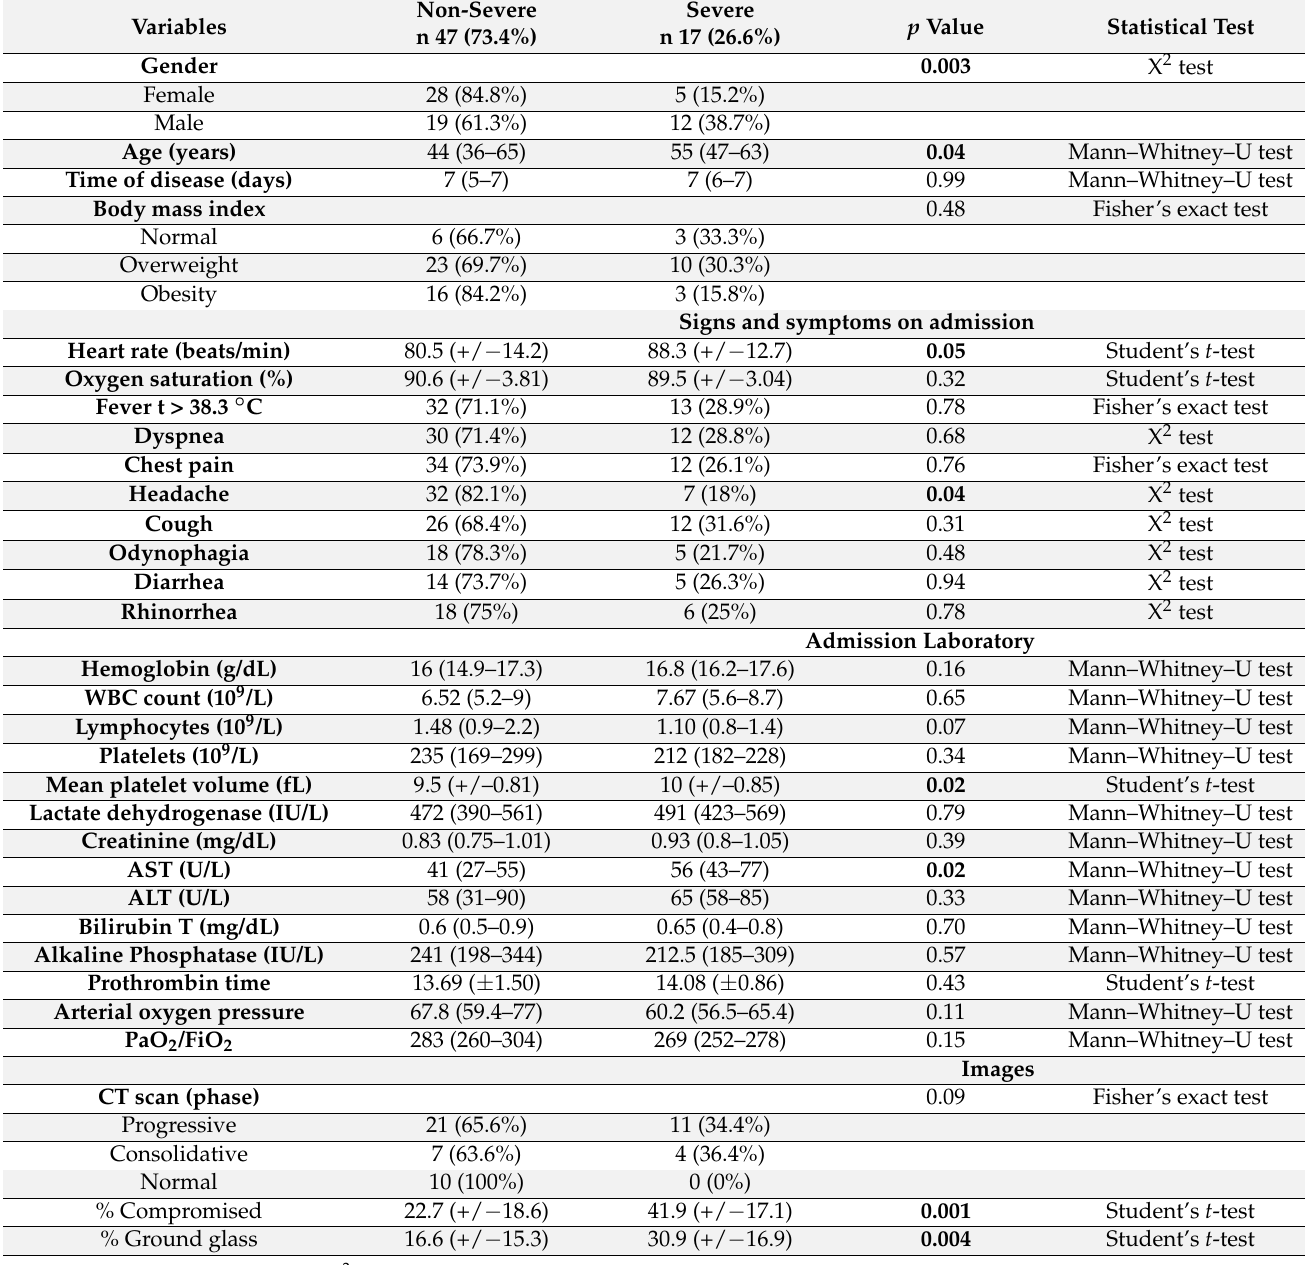
Table 2. Comparison between Severe and Non-severe disease (bivariate analysis).